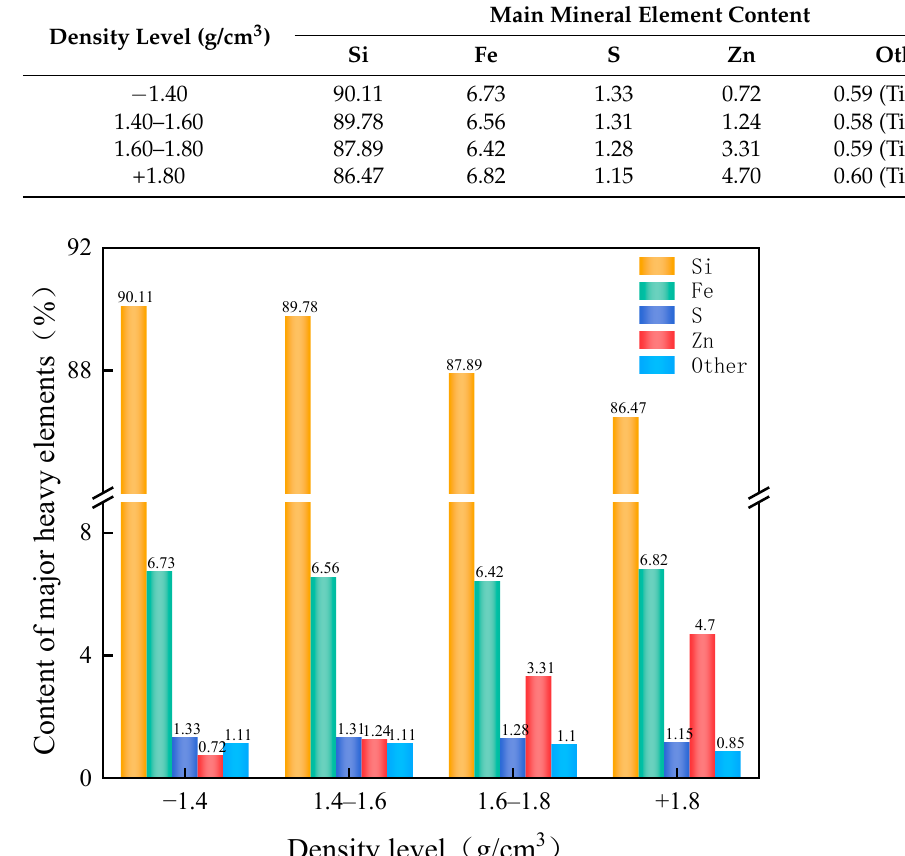
Q Figure 6. Major mineral composition of mineral-enrichment area. 5.2. Numerical Simulation Results The feeding speed of the feeding pipe was set at 8 m/s. The model was numerically simulated when the rotational speed of the cylinder was set at 300 r/min, 500 r/min, 700